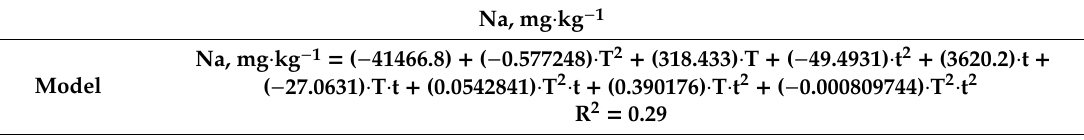
Table A18. The statistical parameters of polynomial regression analysis of the influence of SS torrefaction temperature and residence time on the Na content in